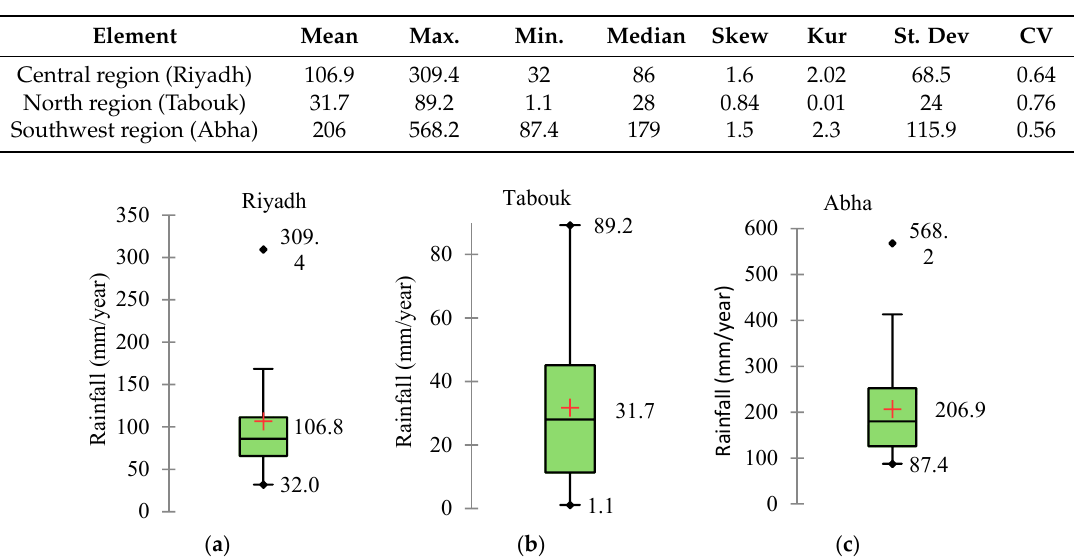
Figure 3. Box plots of rainfall for Riyadh ( a ), Tabouk ( b ) and Abha ( c ) representing the central, north and southwest regions. Bottom and top of the boxes represent the first quartile (Q1) and the third quartile (Q3) respectively. The lower whisker extends up to (Q1 − 1.5 × (Q3 − Q1)) and upper whisker extends up to (Q3 + 1.5 × (Q3 − Q1)). The horizontal lines within the box represent the medians of the data. Values larger than Q3 or smaller than Q1 by at least 1.5 times the interquartile range (IQR) are outliers. The (+) sign indicates the mean values of the